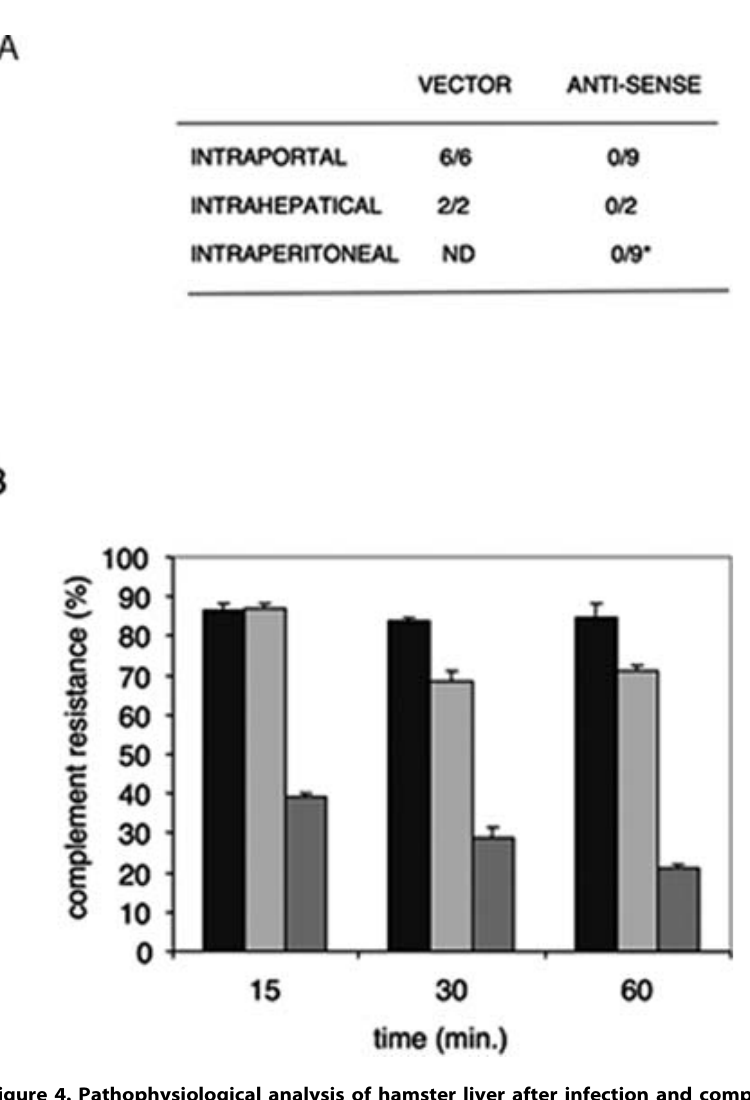
Figure 4. Pathophysiological analysis of hamster liver after infection and complement resistance with EhPIG-M1-AS parasites. A. Summary of different sets of infection by several routes. Notice the absence of abscesses when the infection was performed with the EhPIG-M1-AS strain induced for antisense RNA production compared with the controls. Animals (EhPIG-M1-AS strain infected) were fed with tetracycline three days prior to the inoculation and during the seven days of the experiment. B. Resistance of parasites to blood complement. The parasites from the wild type strain (black columns, (WT), and tetracycline treated control (lightly grey columns, CTL) and tetracycline treated anti-sense (grey columns, AS) strains were incubated in the presence of hamster serum diluted to 30%. Entire cells were counted under the microscope. Serum heated at 56¡C (heat inactivated) was used as a control showing 100% survival of all kind of parasites. Notice that the strain carrying the anti-sense RNA was significantly lysed compared with the control (plasmid vector) and with the wild type